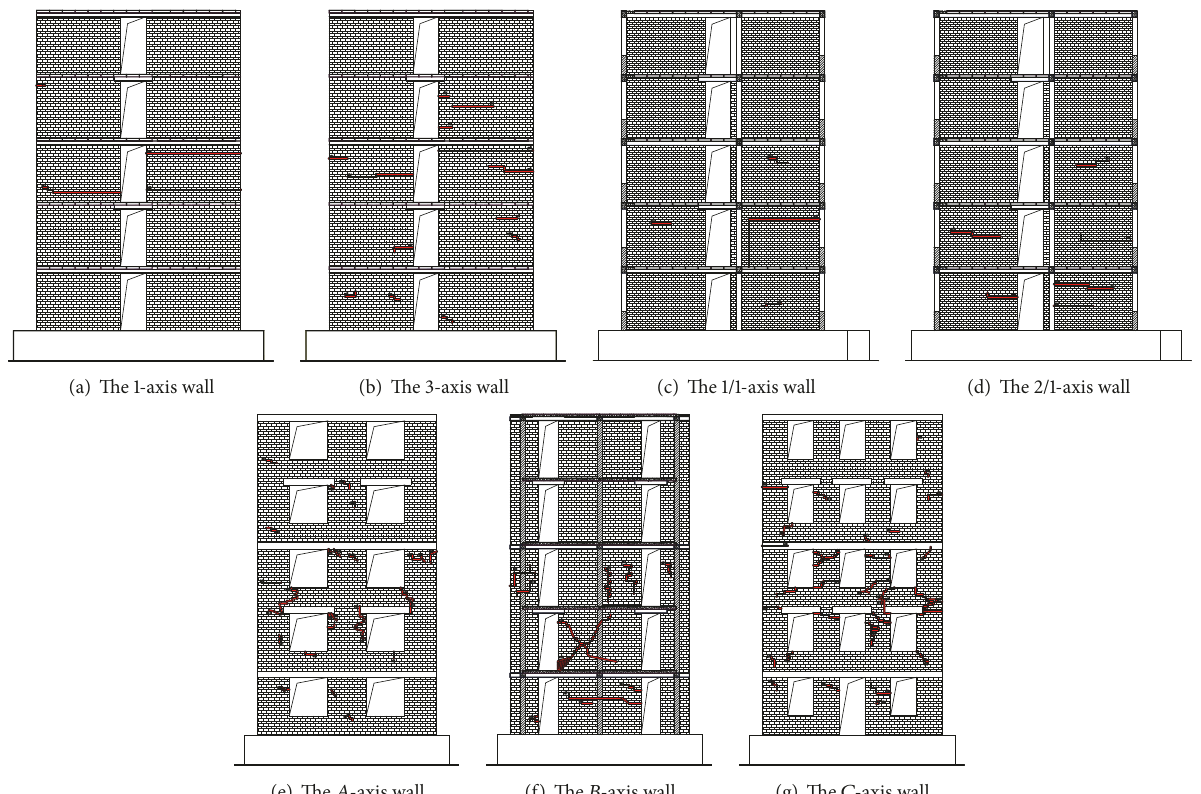
Figure 7: The crack pattern of USMS model at the last stage (target PGA = 0.55